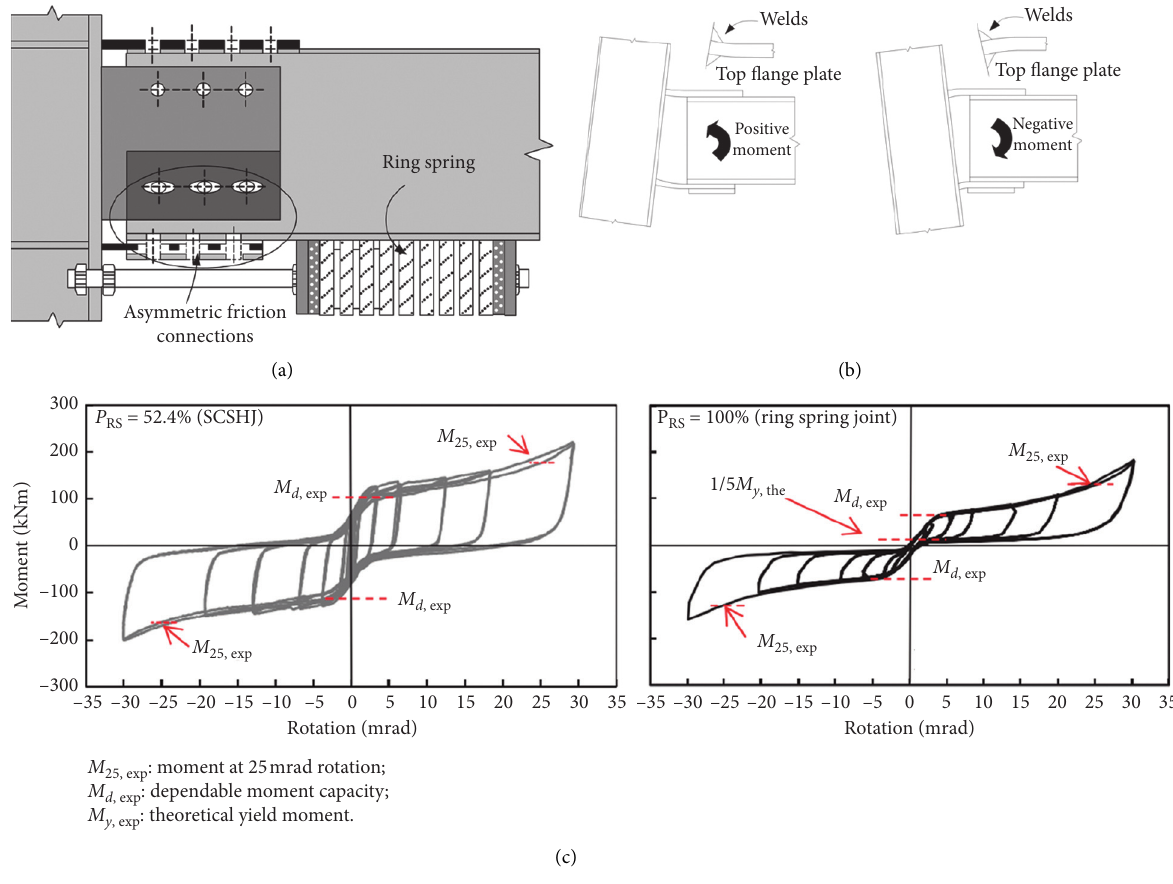
Figure 9: Schematic and behavior of SCSHJ: (a) SCSHJ layout; (b) joint rotation; (c) moment-rotation relationship (adapted from